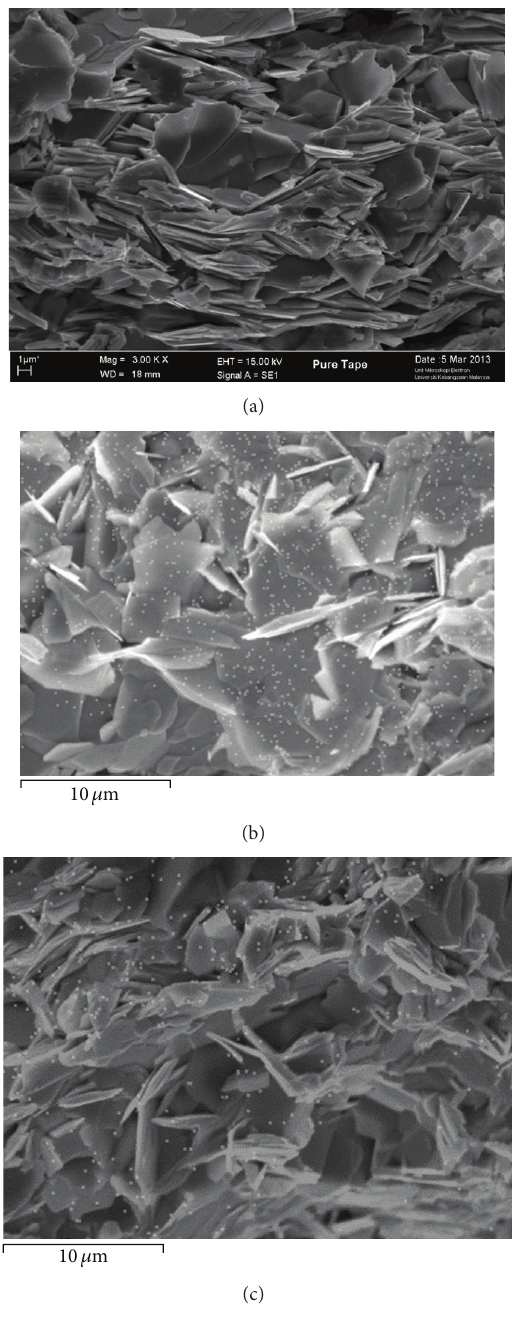
Figure 2: SEM micrographs of (Bi, Pb)-2223(MgO) 𝑥 = 0 wt.%, (b) 𝑥 = 0.10 wt.% of 20nm MgO, and (c) 𝑥 = 0.01 wt.% of 40 nm MgO. The dots refer to